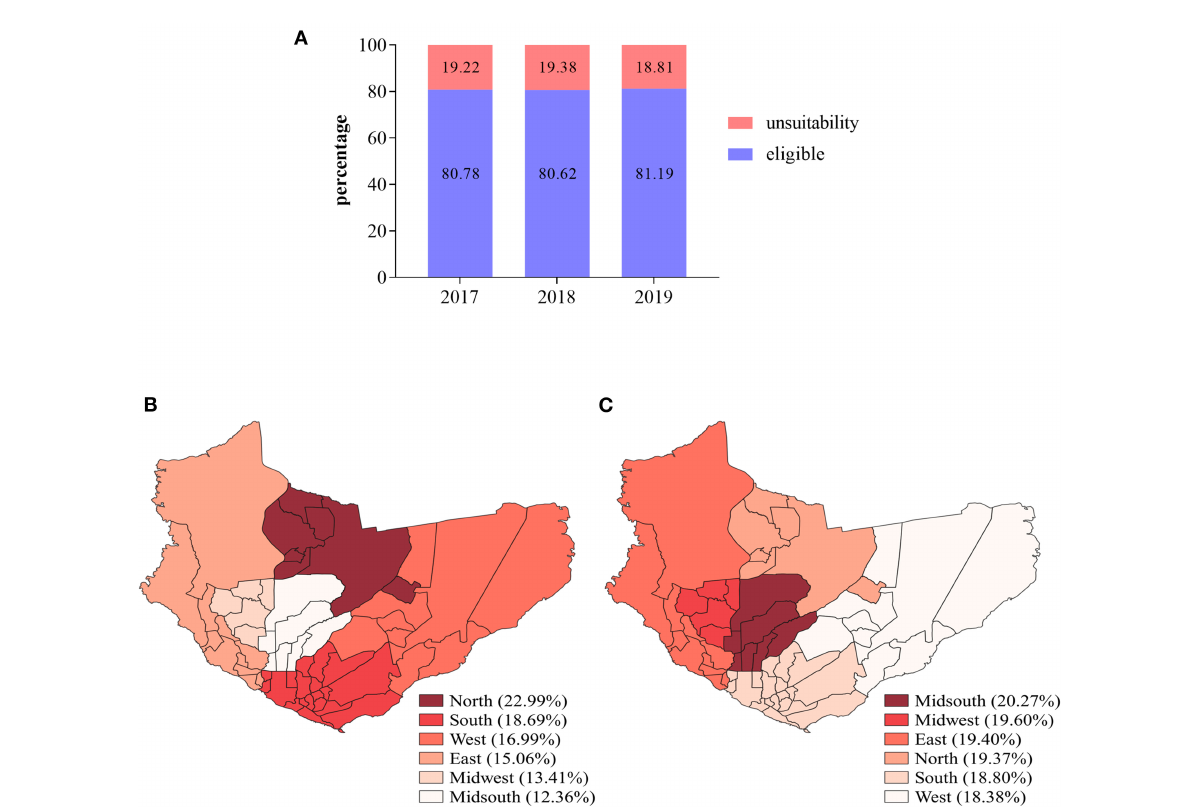
FIGURE1 Total of suitable and unsuitable donors in the study population in the period 2017–2019. (A) Rates of suitable and unsuitable donors according to the year. (B) Site map showing the percentage of donors according to the area of the city of Manaus. (C) Site map showing unsuitability rates according to the area of the city of Manaus. Maps were built using the WGS1984 datum (worldclim software